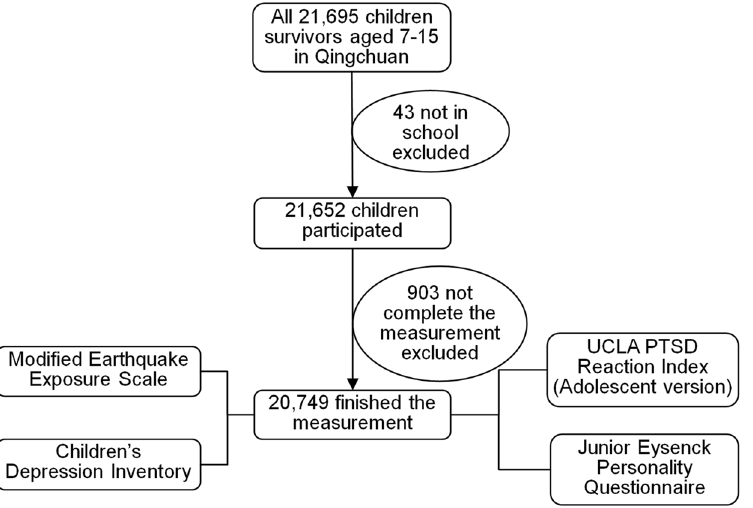
Figure 1. Sampling Stages for Children Survivors in Qingchuan, Sichuan Province Following the Wenchuan